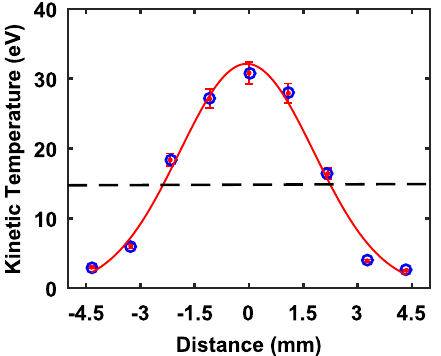
Figure 3. Temperature profile of the Phase coexisting structure. Zero of the X-axis is the center of the structure and the dotted line shows the melting